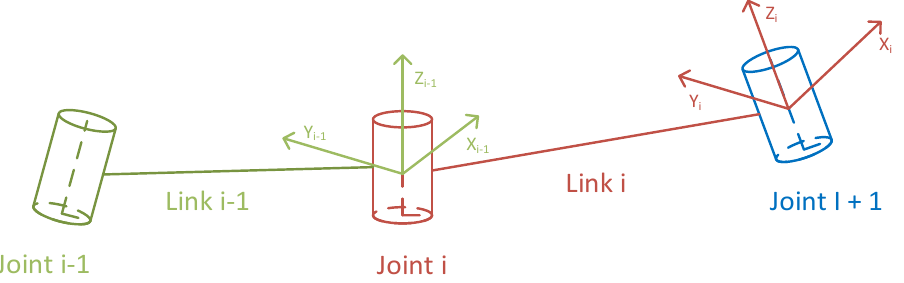
Figure 2. Relationship Between Two Adjacent Links.